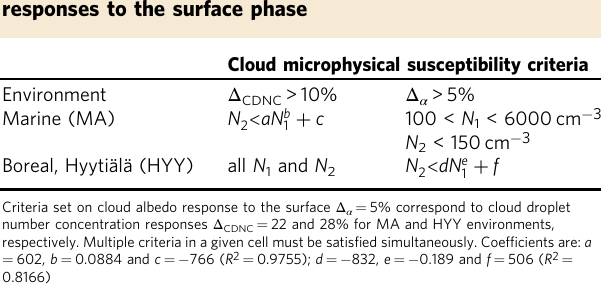
Table 4 Aerosol size-distribution criteria, established from Fig. 4a and d, yielding signi fi cant cloud microphysical responses to the surface